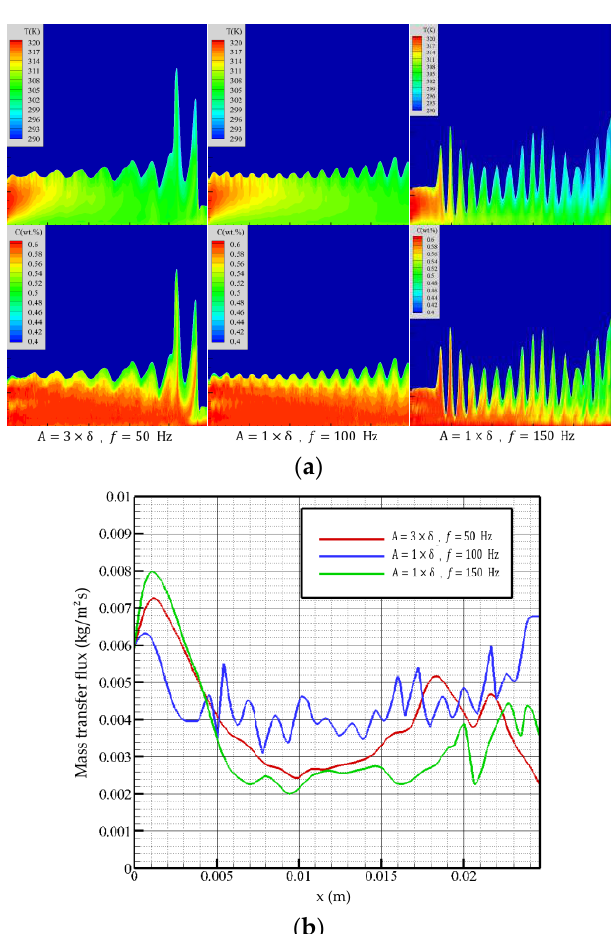
Figure 9. Falling-film absorption effects with different vibration parameters. ( a ) Temperature (top figure) and concentration (bottom figure) distributions, ( b ) mass transfer flux curves of membrane surfaces by different vibration parameters.